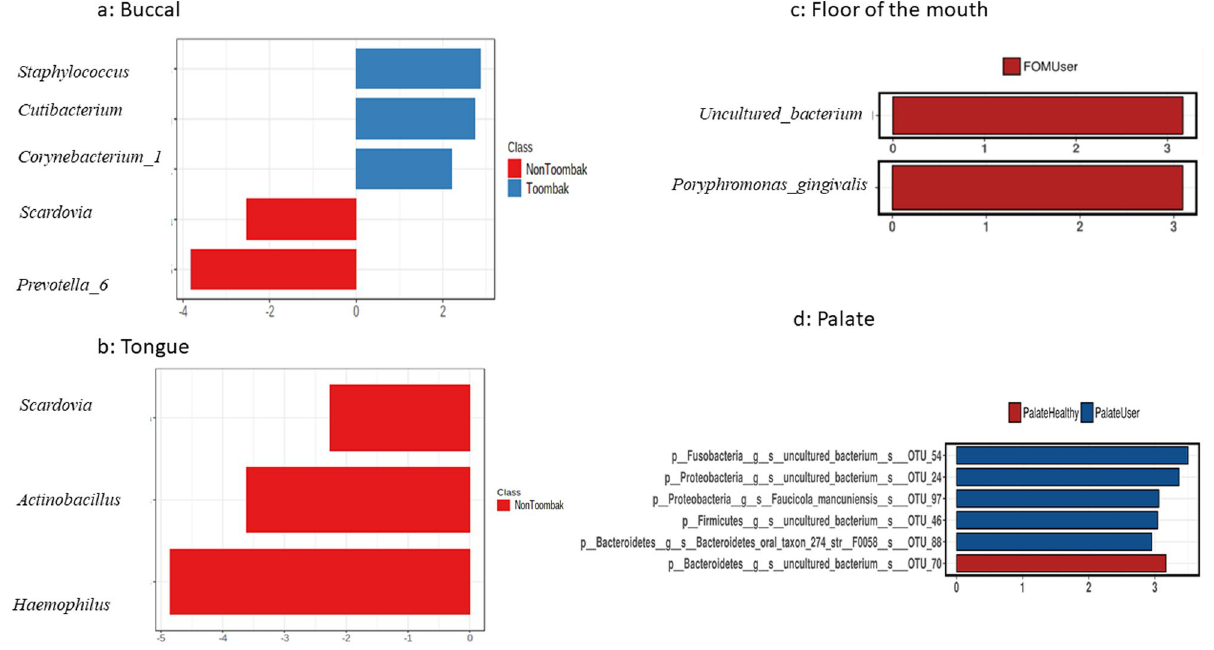
Figure 7. LEfSe plotting of the four oral mucosal locations. ( a ) Buccal cheek microbiome. Staphylococcus, Corynebacterium_1 and Cutibacterium were the most discriminant genera in Toombak users while Prevotella and Scardovia were found in non-users. ( b ) Dorsum tongue microbiome. Haemophilus, Actinobacillus, and Scardovia were discriminant in the dorsum tongue of non-users of Toombak. ( c ). The floor of the mouth microbiome. uncultured bacterium (LDA = 3.1) and Porphyromonas gingivalis (LDA = 3.09) are the most distinct microbiome components in the floor of the mouth of Toombak users. ( d ) Hard palate microbiome. Uncultured bacterium from the phyla Fusobacteria and Proteobacteria , and the species, Faucicola mancuniensis are observed in Toombak users while uncultured bacterium from the phyla Bacteroidetes are discriminant of